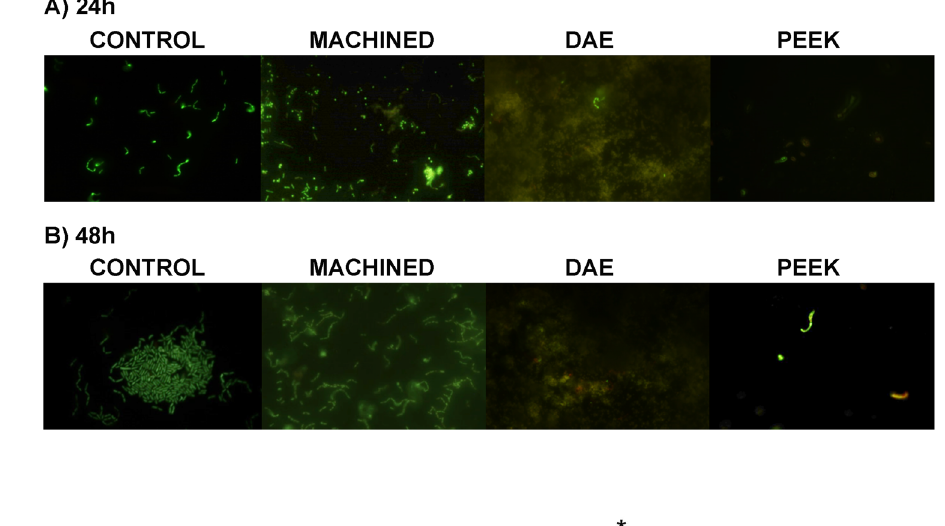
Fig. 6 Comparison of total bio fi lm biomass for the studied S. oralis bio fi lm developed on titanium discs machined, DAE and PEEK ones, after 24 and 48 h of incubation (error bars = ± standard deviation), determined by crystal violet staining (* p -value < 0.05)